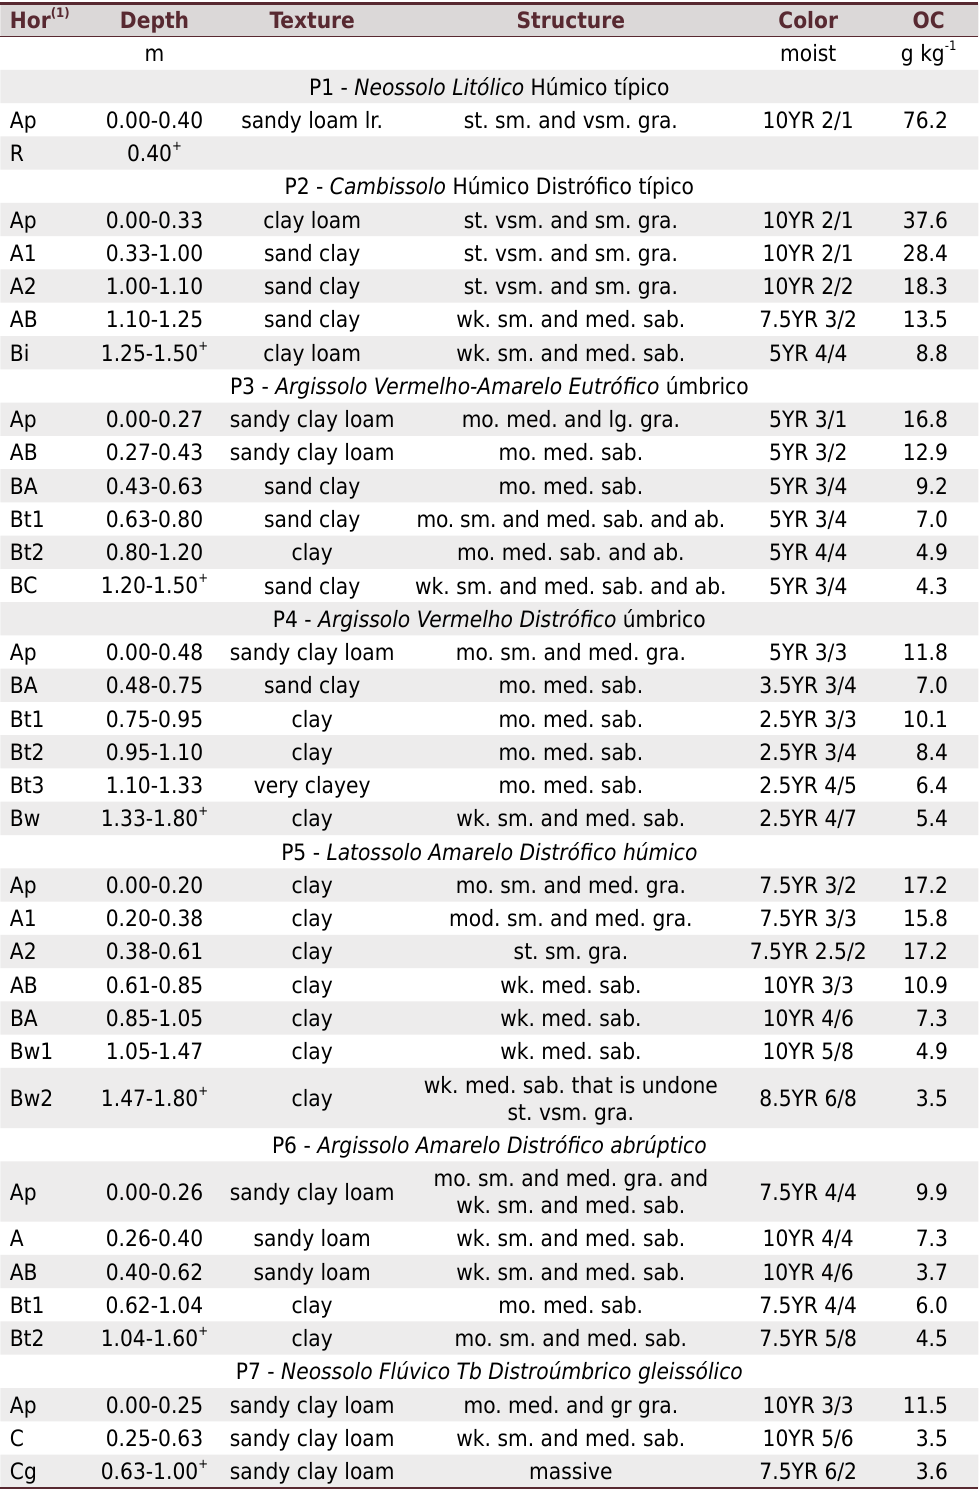
Table 2. Morphological properties and organic carbon of the soils from the Pito Aceso basin, municipality of Bom Jardim